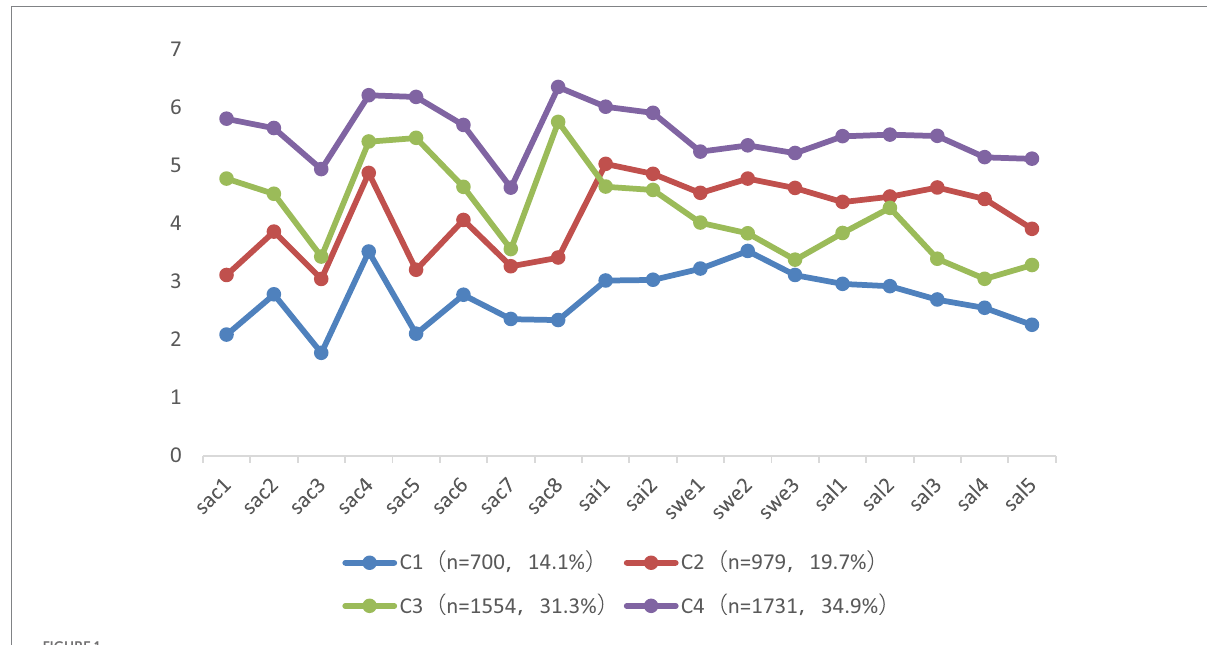
FIGURE 1 Mean scores of indicators for four-profile solution ( N = 4,964). sac = satisfaction with academic cultivation; sai = satisfaction with academic interaction; swe = satisfaction with economics; sal = satisfaction with academic